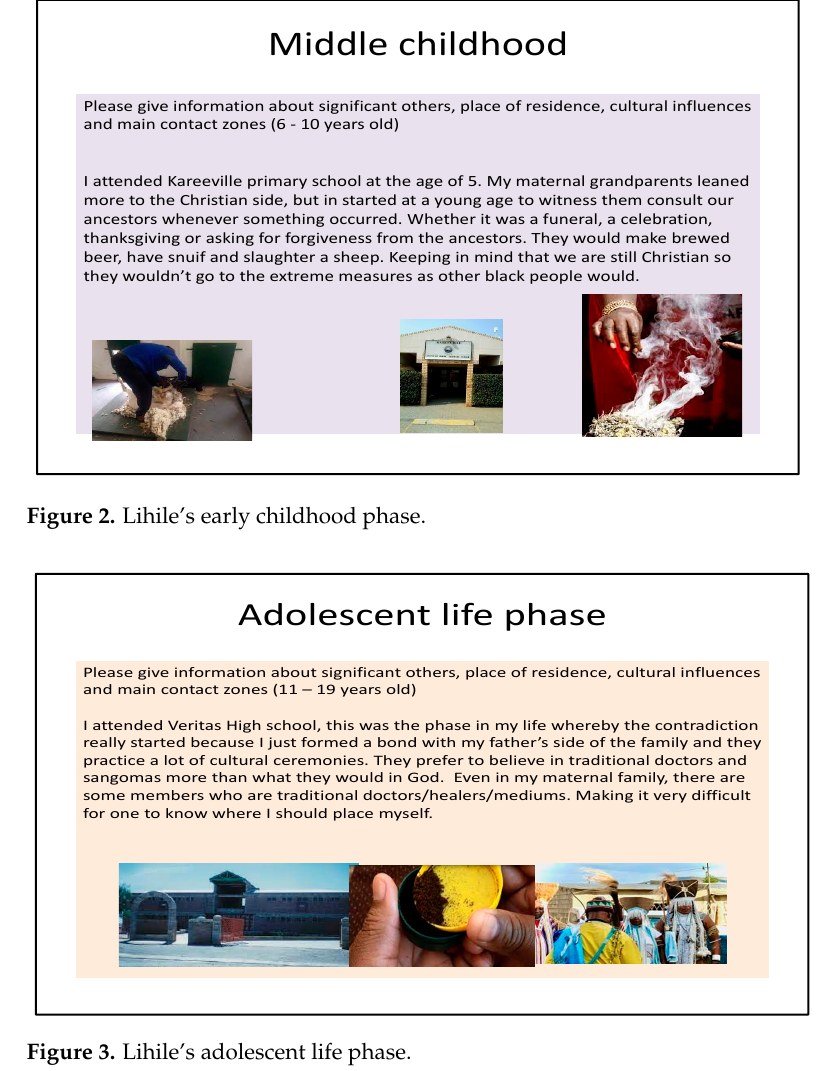
Figure 4. Lihile’s adult life phase. Figure 5. Tanaka’s timeline of her first life phase.